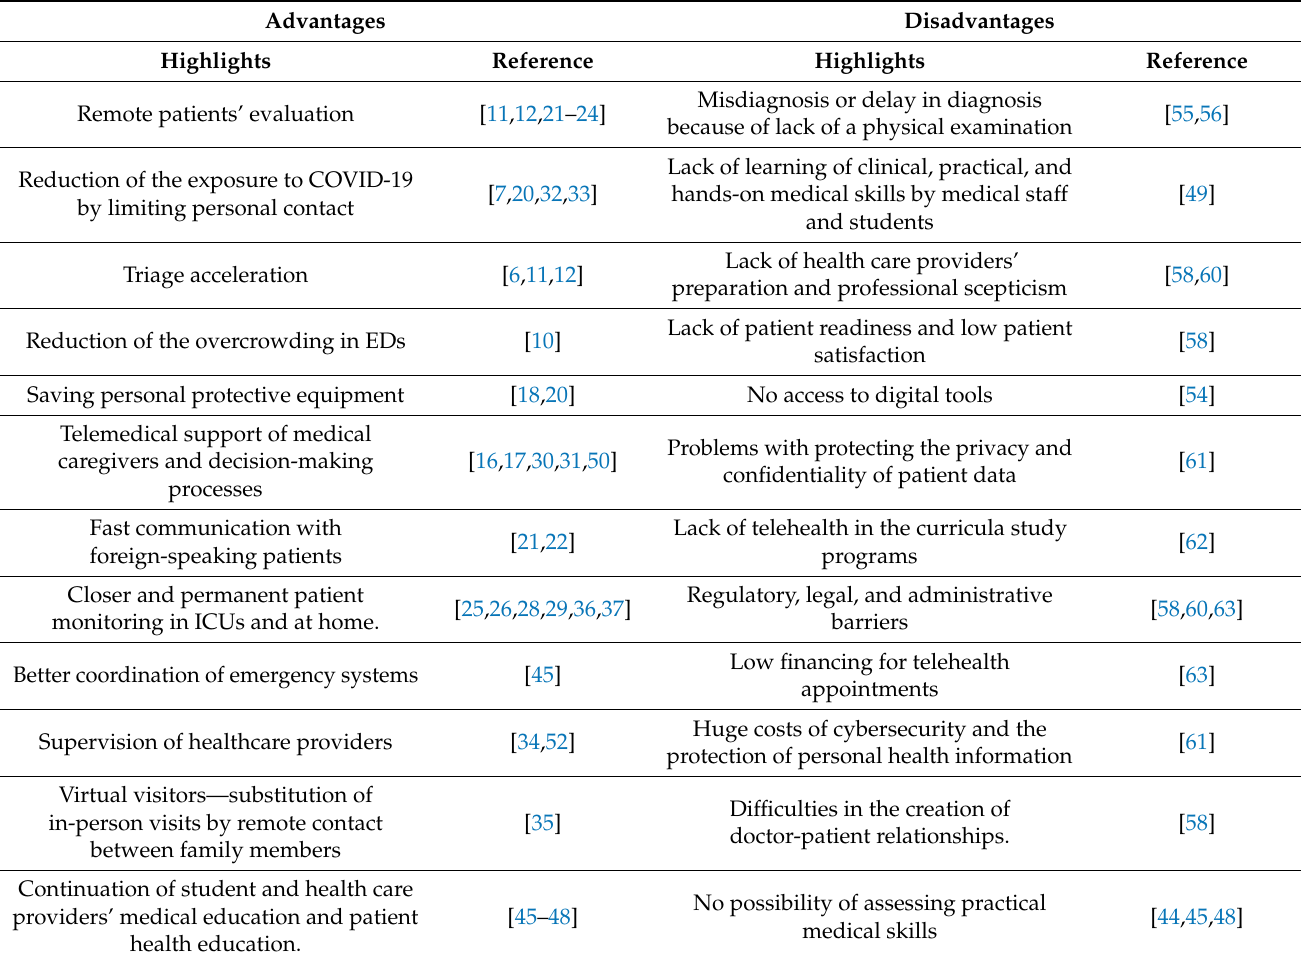
Table 1. Advantages and disadvantages of telemedicine in emergency practice in the COVID-19